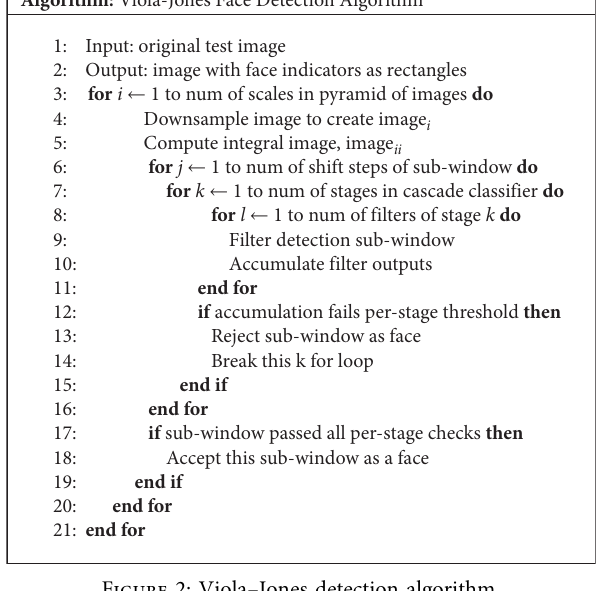
Algorithm: Viola-Jones Face Detection Algorithm